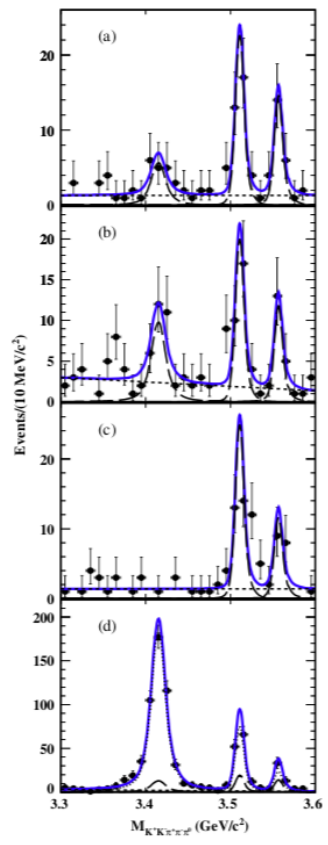
Figure 1. Simultaneous fit to the M ( K + K − π + π − π 0 ) distributions in the sidebands (A, B, and C) and the signal (D) regions. The dots with error bars are data, the solid lines are the fit results, and the dot- ted lines represent the signal com- ponents. The long-dashed line is background normalized using the si- multaneous fit to the ωφ sidebands, and the short-dashed line is the re- maining